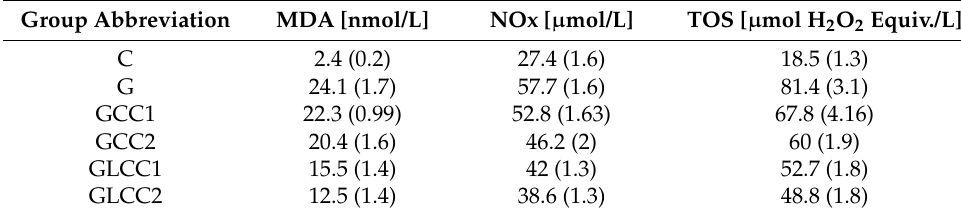
Table 1. Serum levels of oxidative stress intensity.